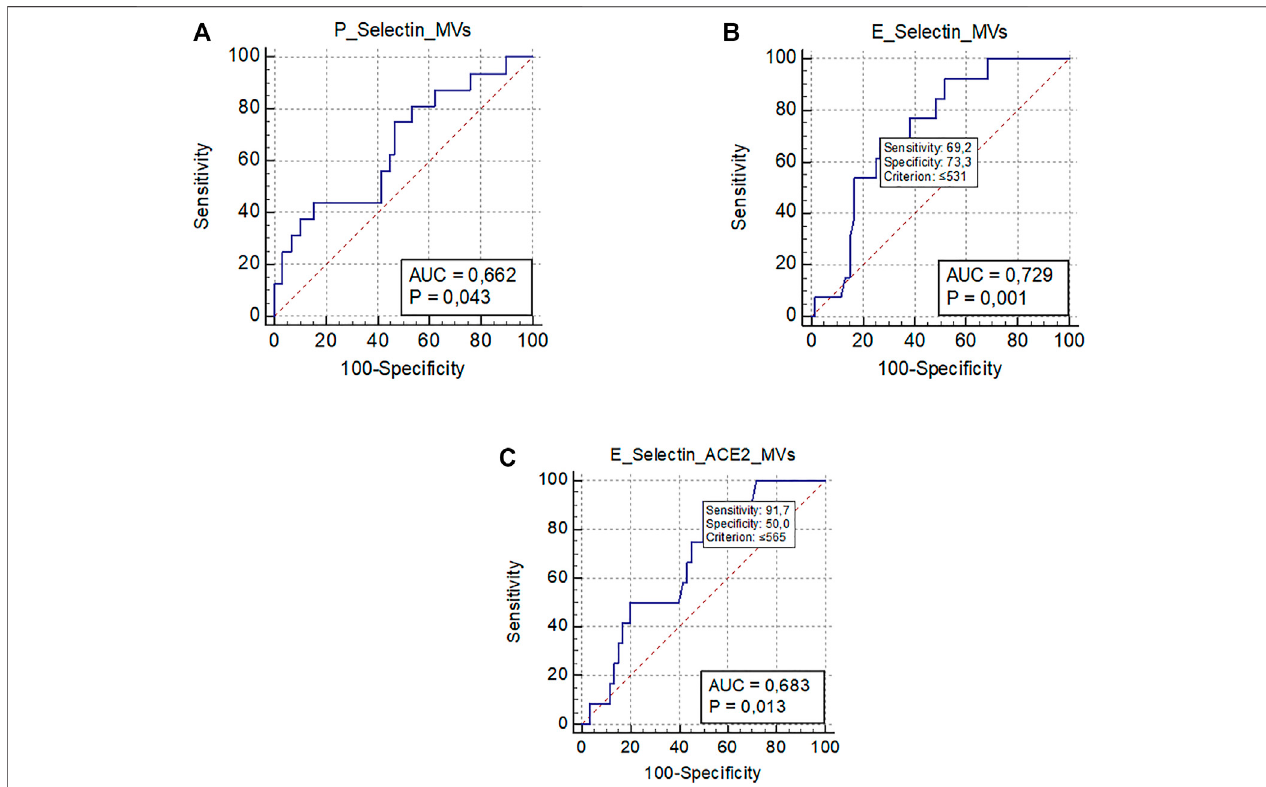
FIGURE 3 | ROC curve analysis representing signi fi cant associations between MVs levels and clinical outcomes. (A) Association between platelet-derived MVs (P-Selectin +MVs) and venousthromboembolism; (B) Associationbetweenendothelial-derived MVs(E-Selectin+ MVs) and worsening/death; (C) Associationbetween endothelial-derived MVs expressing ACE2 (E-Selectin+ACE2+ MVs) and worsening/death.; Abbreviations: ROC: receiver operating characteristic; MVs: microvesicles; ACE2: angiotensin-converting enzyme-2; AUC: area under the curve.